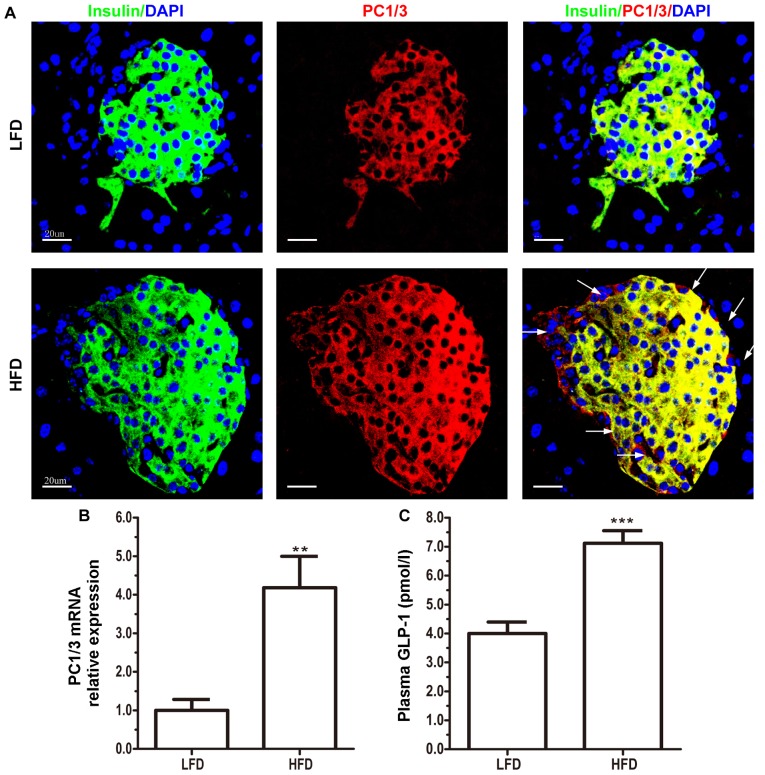
High-fat diet (HFD) induces intra-islet glucagon-like peptide-1 (GLP-1) system activation. (A) Representative images of immunofluorescence staining for insulin (green) and prohormone convertase 1/3 (PC1/3) (red) in the pancreatic islets of mice that were fed a low-fat diet (LFD) (n=6) or a HFD (n=7) for 8 weeks. The arrows indicate the insulin-negative and PC1/3-positive cells. (B) PC1/3 mRNA expression in the pancreata of mice from each group was detected by qPCR. (C) Plasma GLP-1 levels in the mice were detected by insulin enzyme-linked immunosorbent assay (ELISA). LFD compared with HFD; **p<0.01; ***p<0.001.